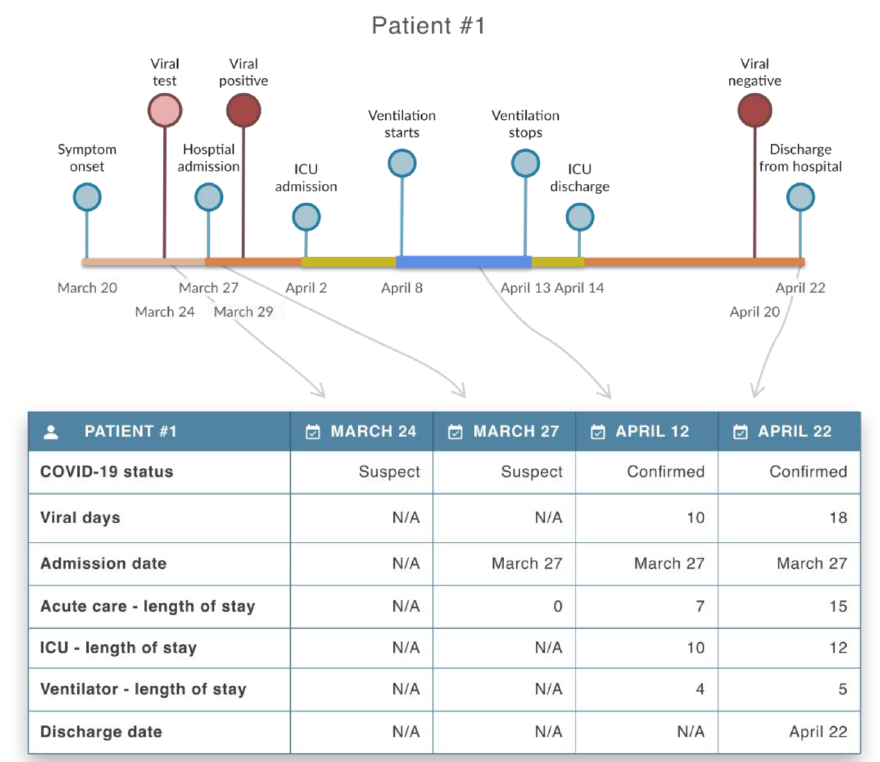
Figure 2: Line Listing for a single